Question: Which kind of chart has been used to present this data?
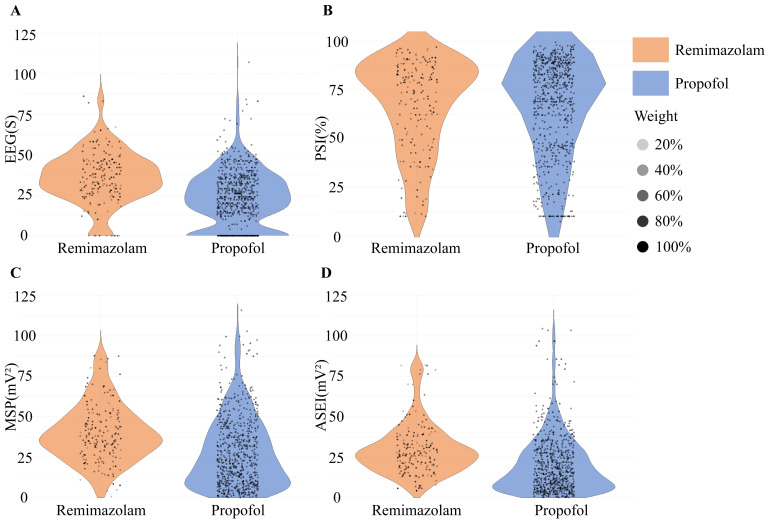
Answer: box